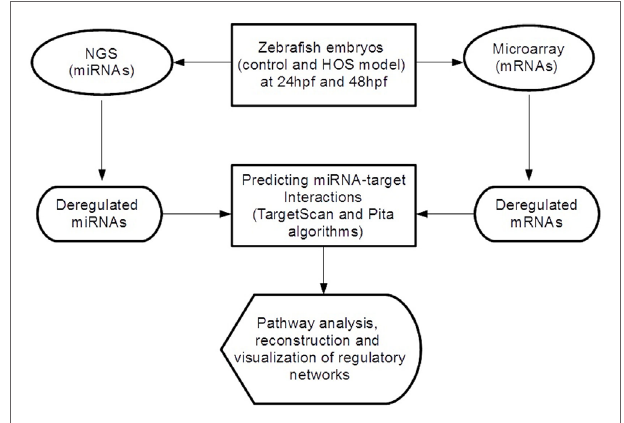
FigUre 1 | Overview of the analytical workflow used in the study to identify inversely correlated putative target genes and to build altered regulatory networks in hOs